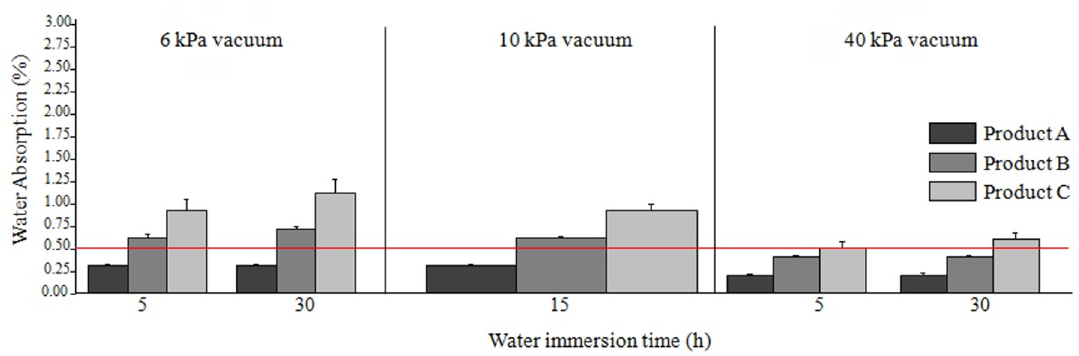
Figure 3. WA in function of the water immersion time obtained by the vacuum method for different vacuum